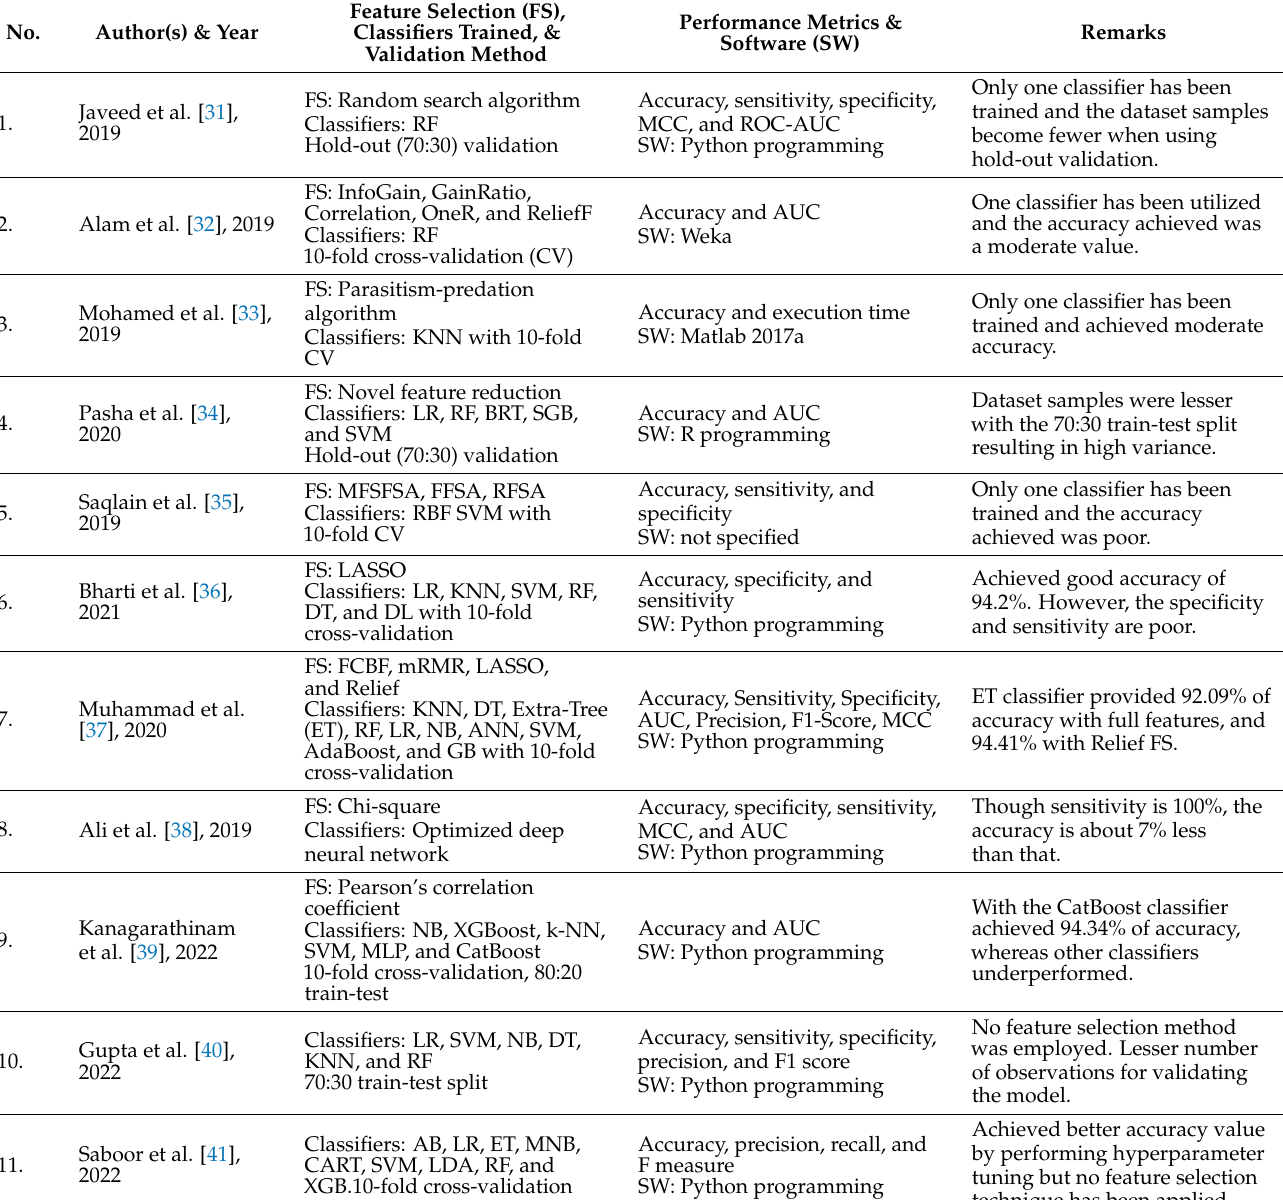
Table 1. Summary of the related